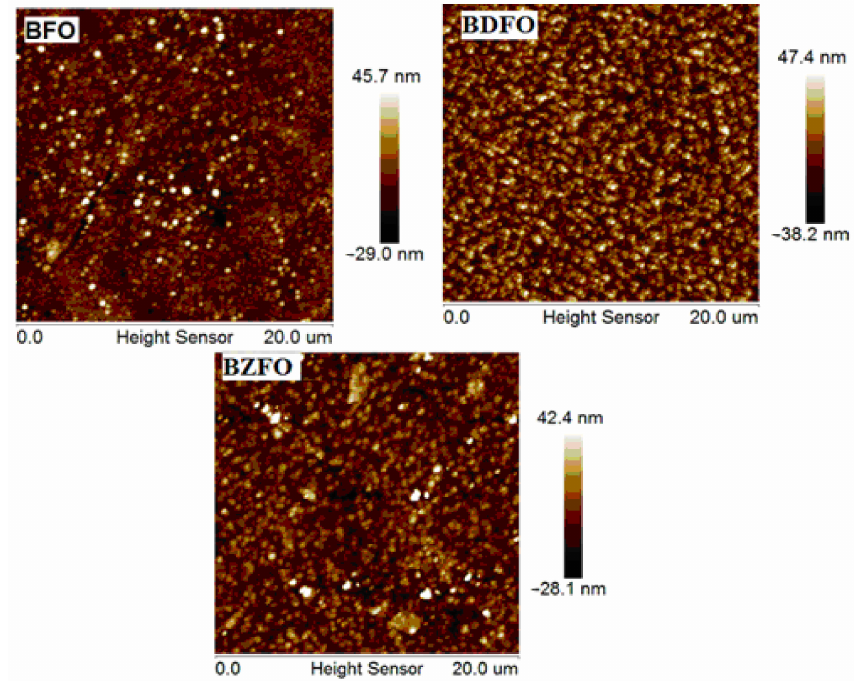
Figure 4. Surface topography images of BFO, BDFO, and BZFO thin films.